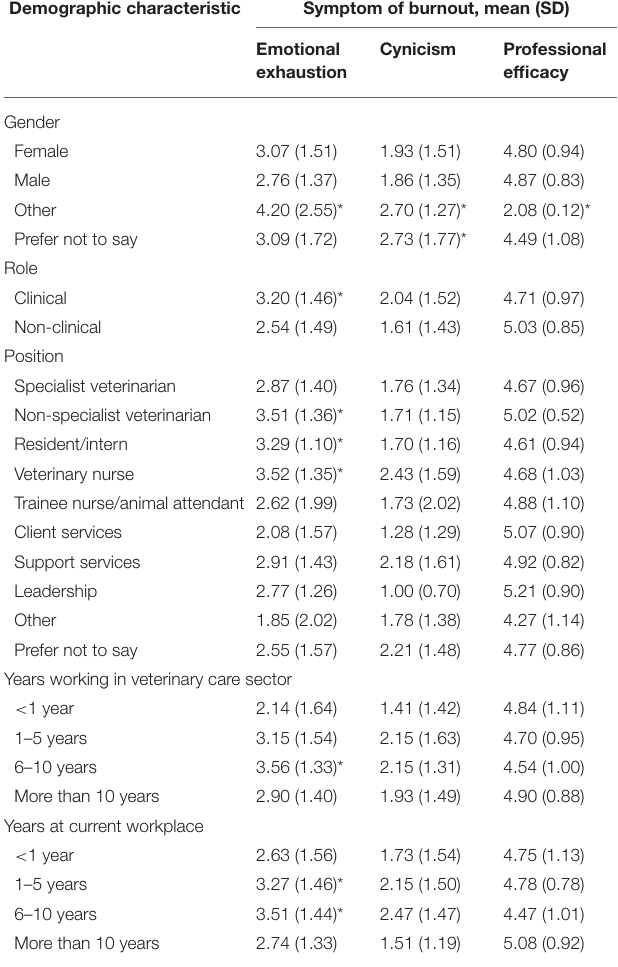
TABLE 3 | Symptoms of burnout according to demographic characteristics.